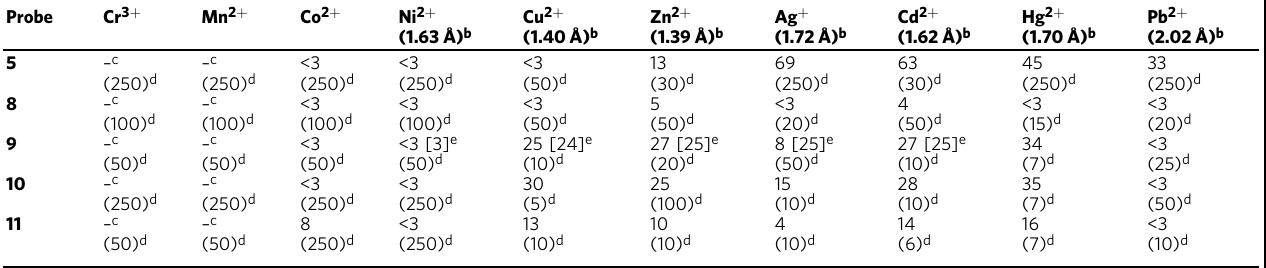
Table 2 Summary of fl uorescence emission shifts (nm) of probes 5 and 8 – 11 upon the addition of various metal ions a . Probe